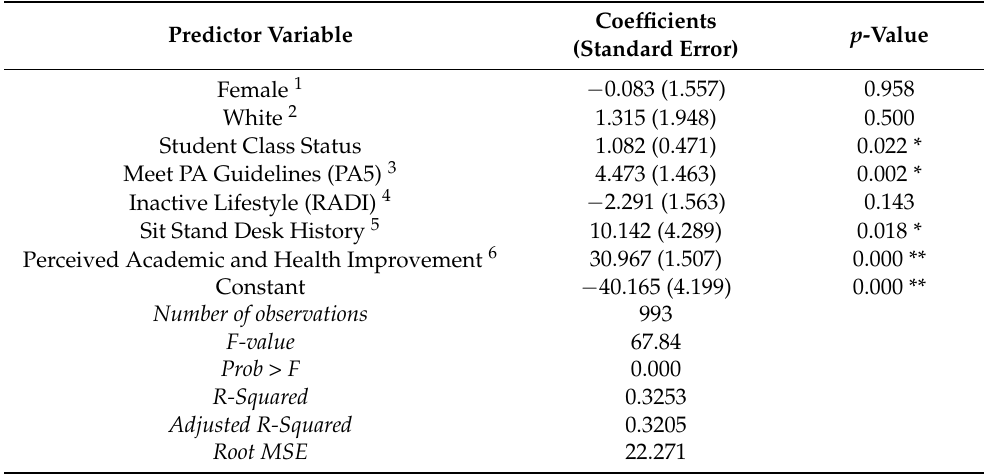
Table 5. Model 1: Linear regression model to predict student favorability of introducing standing desks in college classroom.